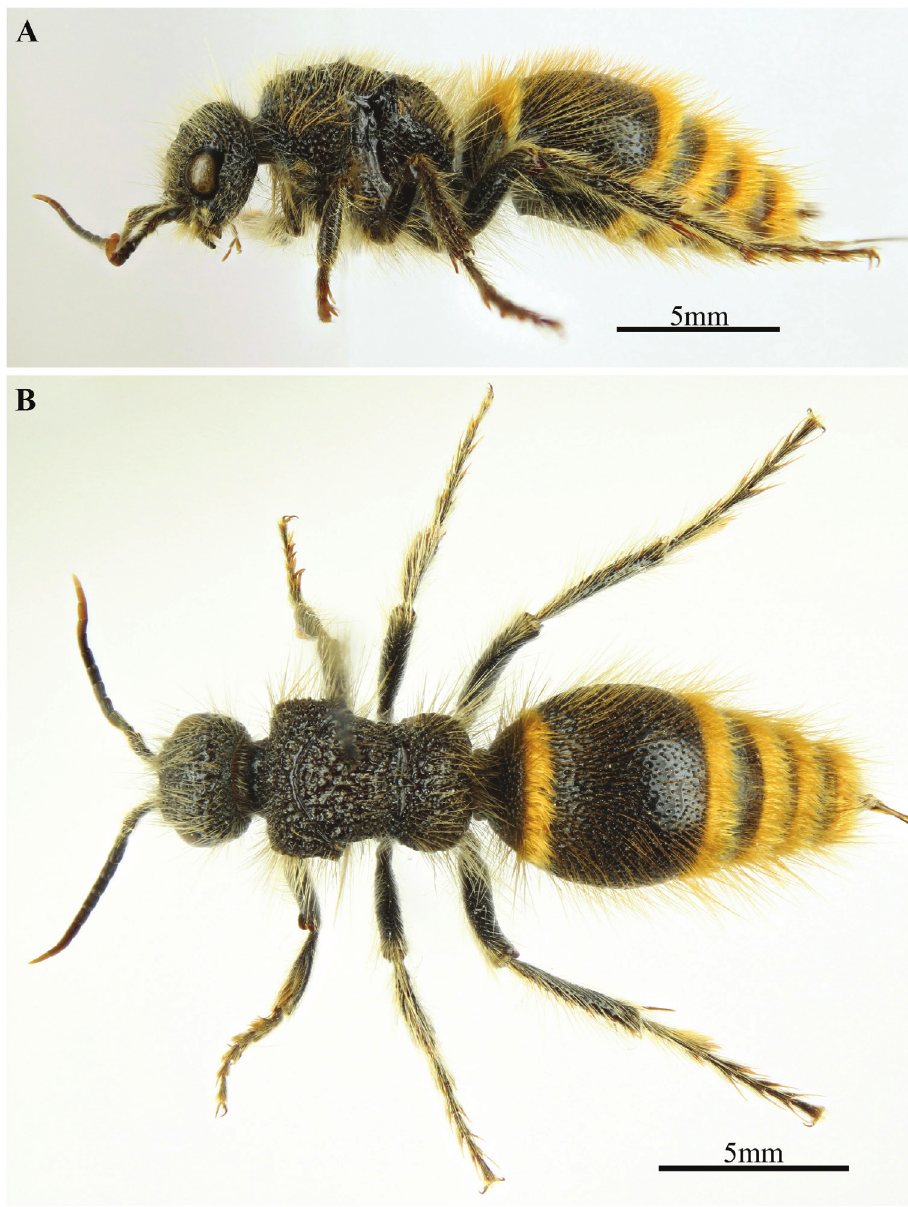
Figure 6. Pseudophotopsis aurea (Klug) (Female) A, B habitus, lateral and dorsal views, respectively. 8A); propodeal dorsal face distinctly widened laterally, sharply declivitous posteriorly (truncate), 0.50–0.55 × as long as maximal width (Figs 7D; 8A); meso- and meta- pleura punctate (Fig. 8A); mid and hind tibiae with strong prolongation at their apices (Fig. 8B, C); hind tibia without a groove on inner face (Fig. 8C); T6 with oval-shaped pygidial area, finely rugose on disc and obliquely striate laterally (Fig.